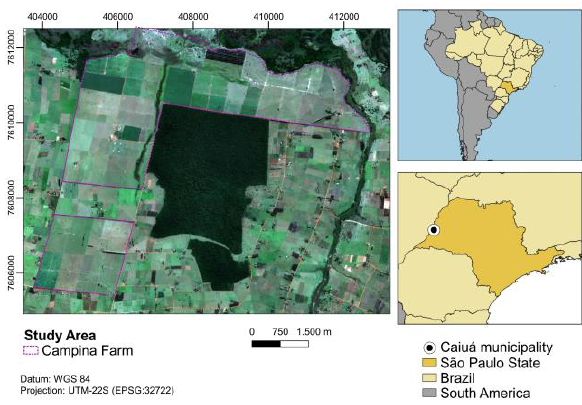
Figure 1 . Location map of the study area.